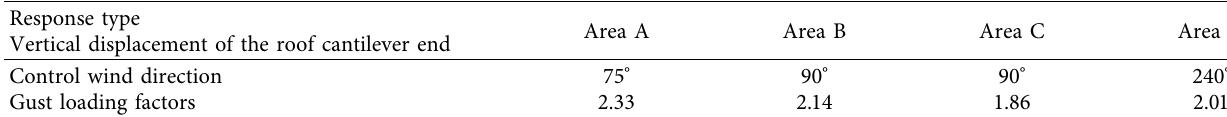
Figure 9: Vertical displacement time histories of the cantilever end in different areas. (a) Area A (75 ° wind angle). (b) Area B (90 ° wind angle). (c) Area C (90 ° wind angle). (d) Area D (240 ° wind angle). Table 1: Gust response factor of each